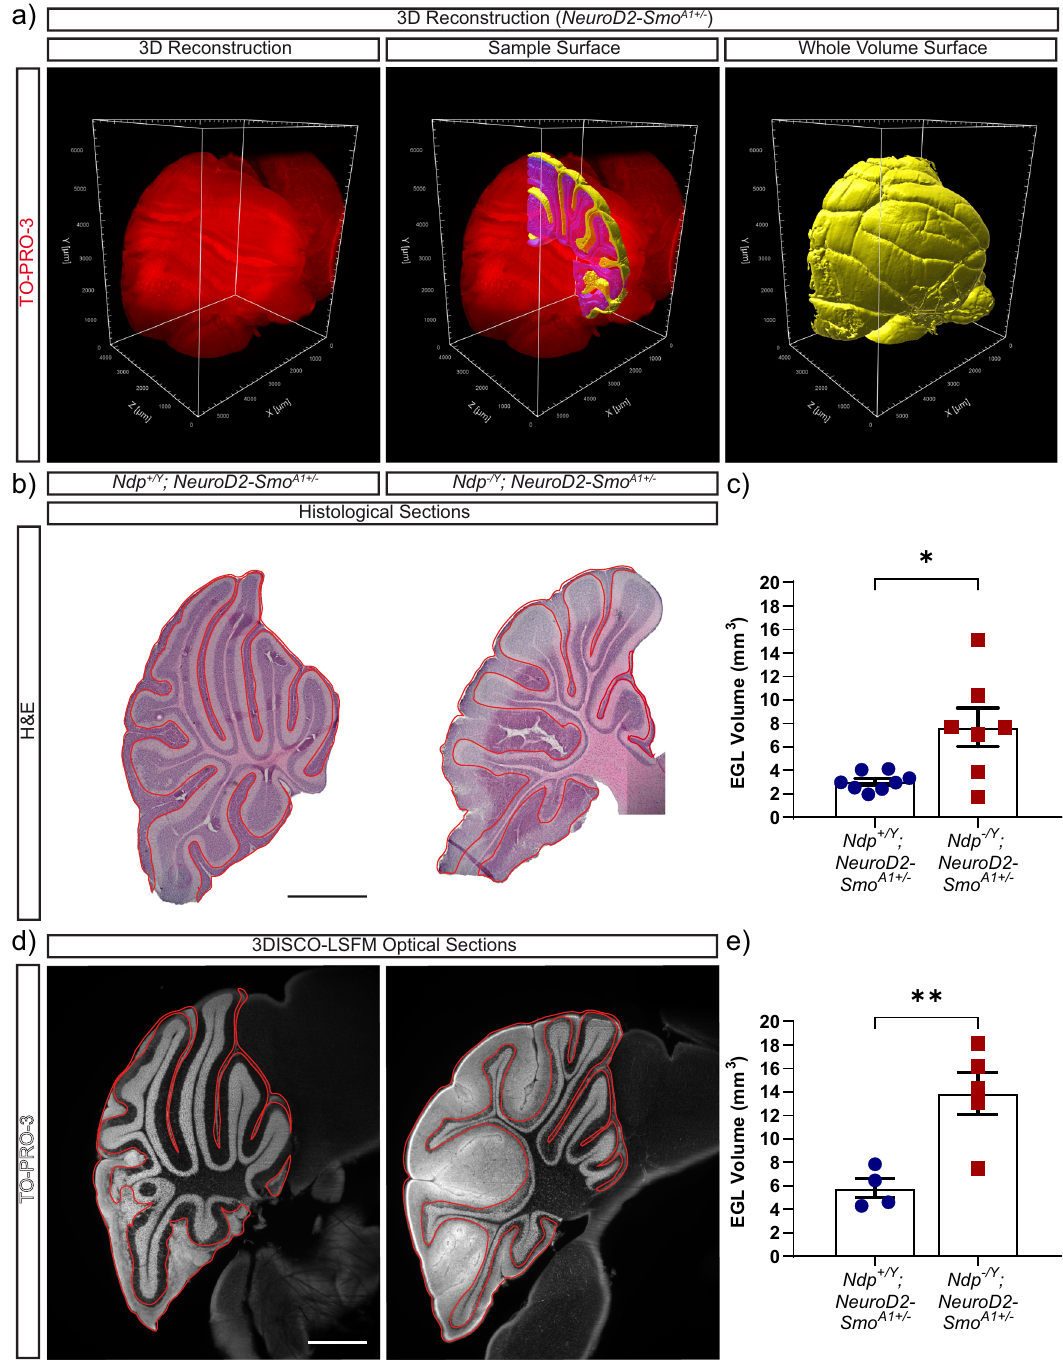
Fig. 3 3DISCO-LSFM analysis of Norrin/Fzd4 dependent external granular layer hyperplasia in the cerebella of Neurod2-Smo A1 + / − mice. a Image processing sequence for EGL volume quanti fi cation from a TO-PRO-3 stained (red) cerebellum of a Neurod2-Smo A1 + / − mouse at P14. Separate EGL (yellow) and IGL (blue) surfaces from a 260 µ m thick region (middle image), were generated to calculate the EGL to total (EGL + IGL) volume ratio. The EGL volume ratio was then multiplied by the volume of the entire cerebellum to calculate total EGL volume (yellow) across the sample. b – e Comparison of H&E-stained serial sections and 3DISCO-LSFM analysis of cerebella of Ndp + /Y ; Neurod2-Smo A1 + / − and Ndp − /Y ; Neurod2-Smo A1 + / − mice at P14. Samples are presented as H&E-stained sections ( b ), or optical sections from TO-PRO-3-stained cleared tissues ( d ). EGL hyperplasia in each section is outlined in red ( b , d ). c In H&E-stained sections, EGL volume of Ndp − /Y ; Neurod2-Smo A1 + / − cerebella ( n = 7 mice) at P14 was signi fi cantly increased compared with controls ( n = 8 mice), * p < 0.05, p = 0.0106 (unpaired two-tailed t -test). e Imaris analysis of 3DISCO-LSFM samples also revealed an increase in EGL volume in Ndp − /Y ; Neurod2-Smo A1 + / − mice ( n = 5), compared to controls ( n = 4), ** p < 0.01, p = 0.0077 (unpaired two-tailed t -test). Error bars represent s.e.m. Volume measurements represent EGL volume for the entire cerebellum. Scale bars: 1000 µ m.